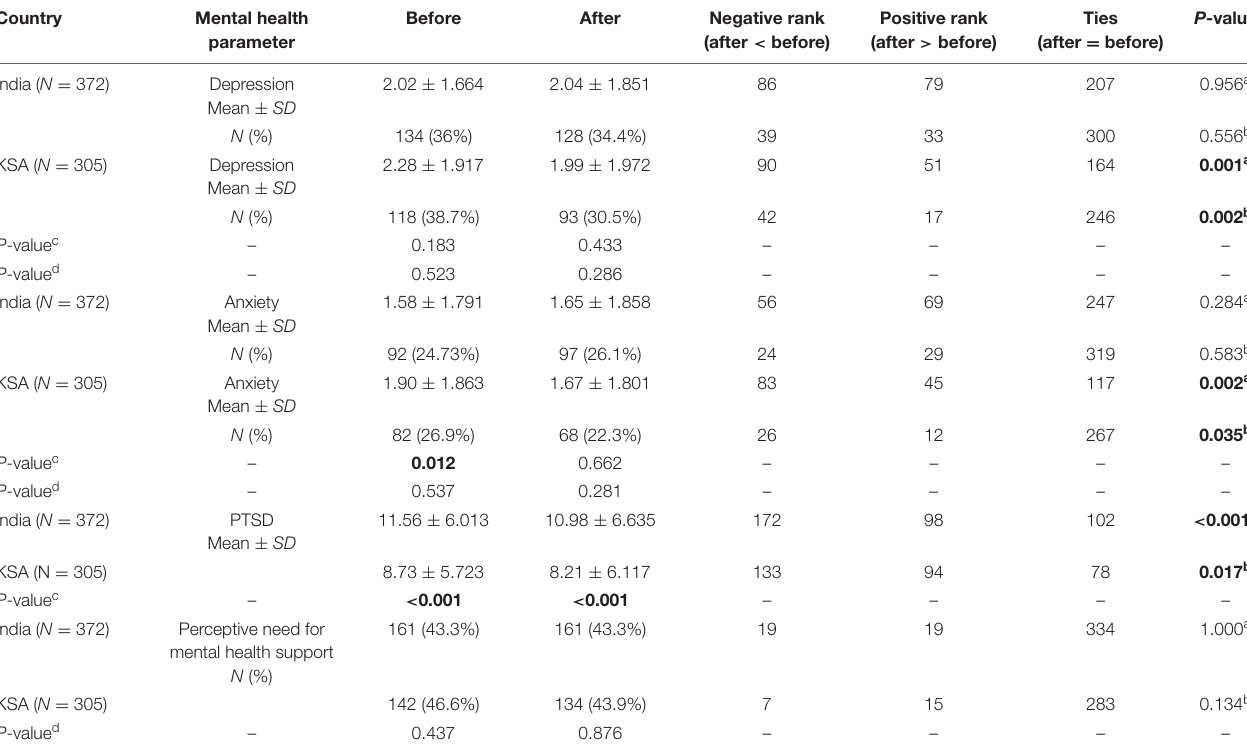
TABLE 1 | Comparison of mental health parameters before and after the advent of COVID-19 vaccines. Country Mental health Before After Negative rank parameter